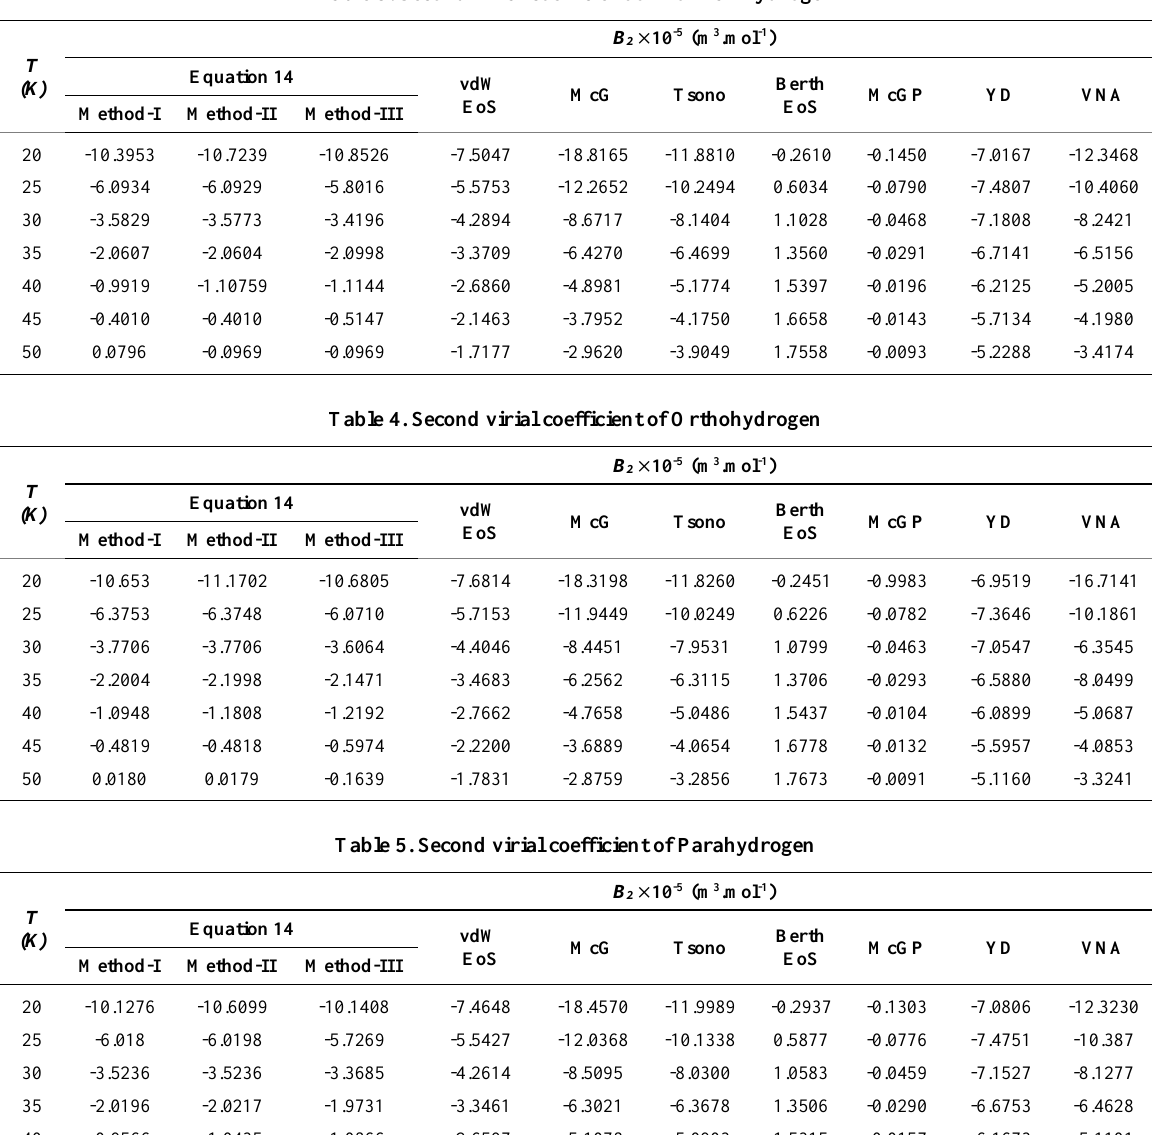
Table 3. Second virial coefficient of Normal Hydrogen